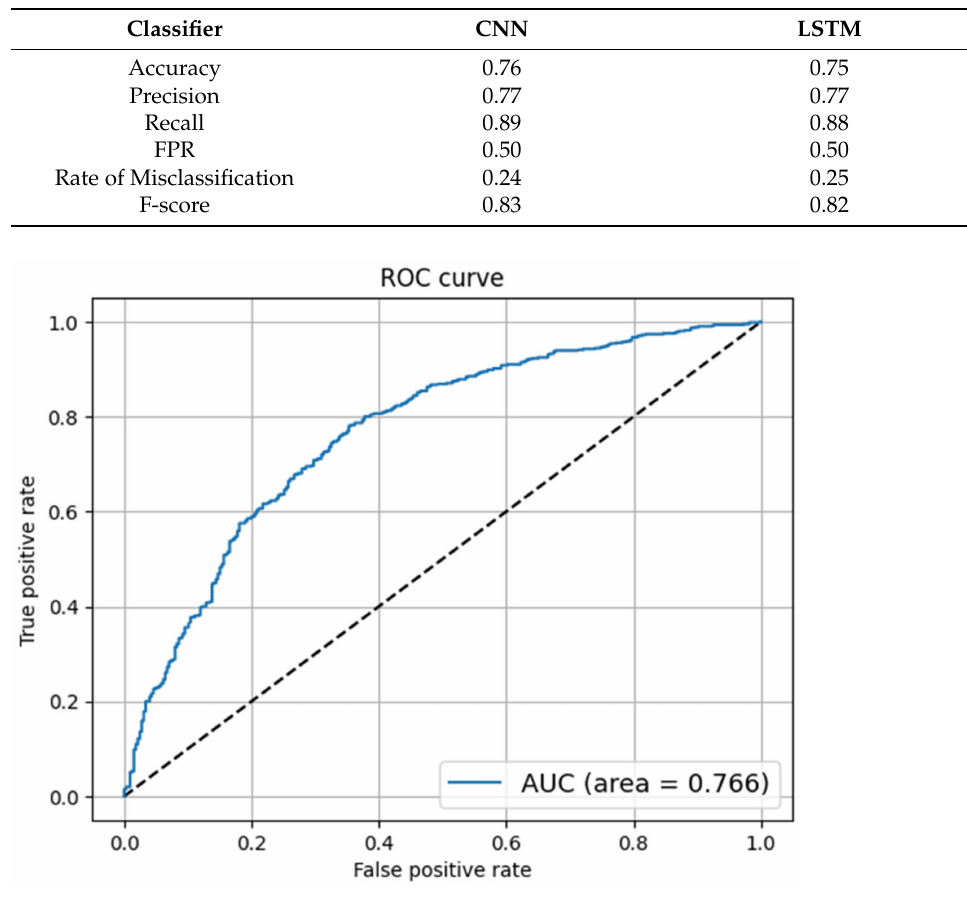
Figure 3. ROC curve of CNN on COVID-19 Fake News dataset.